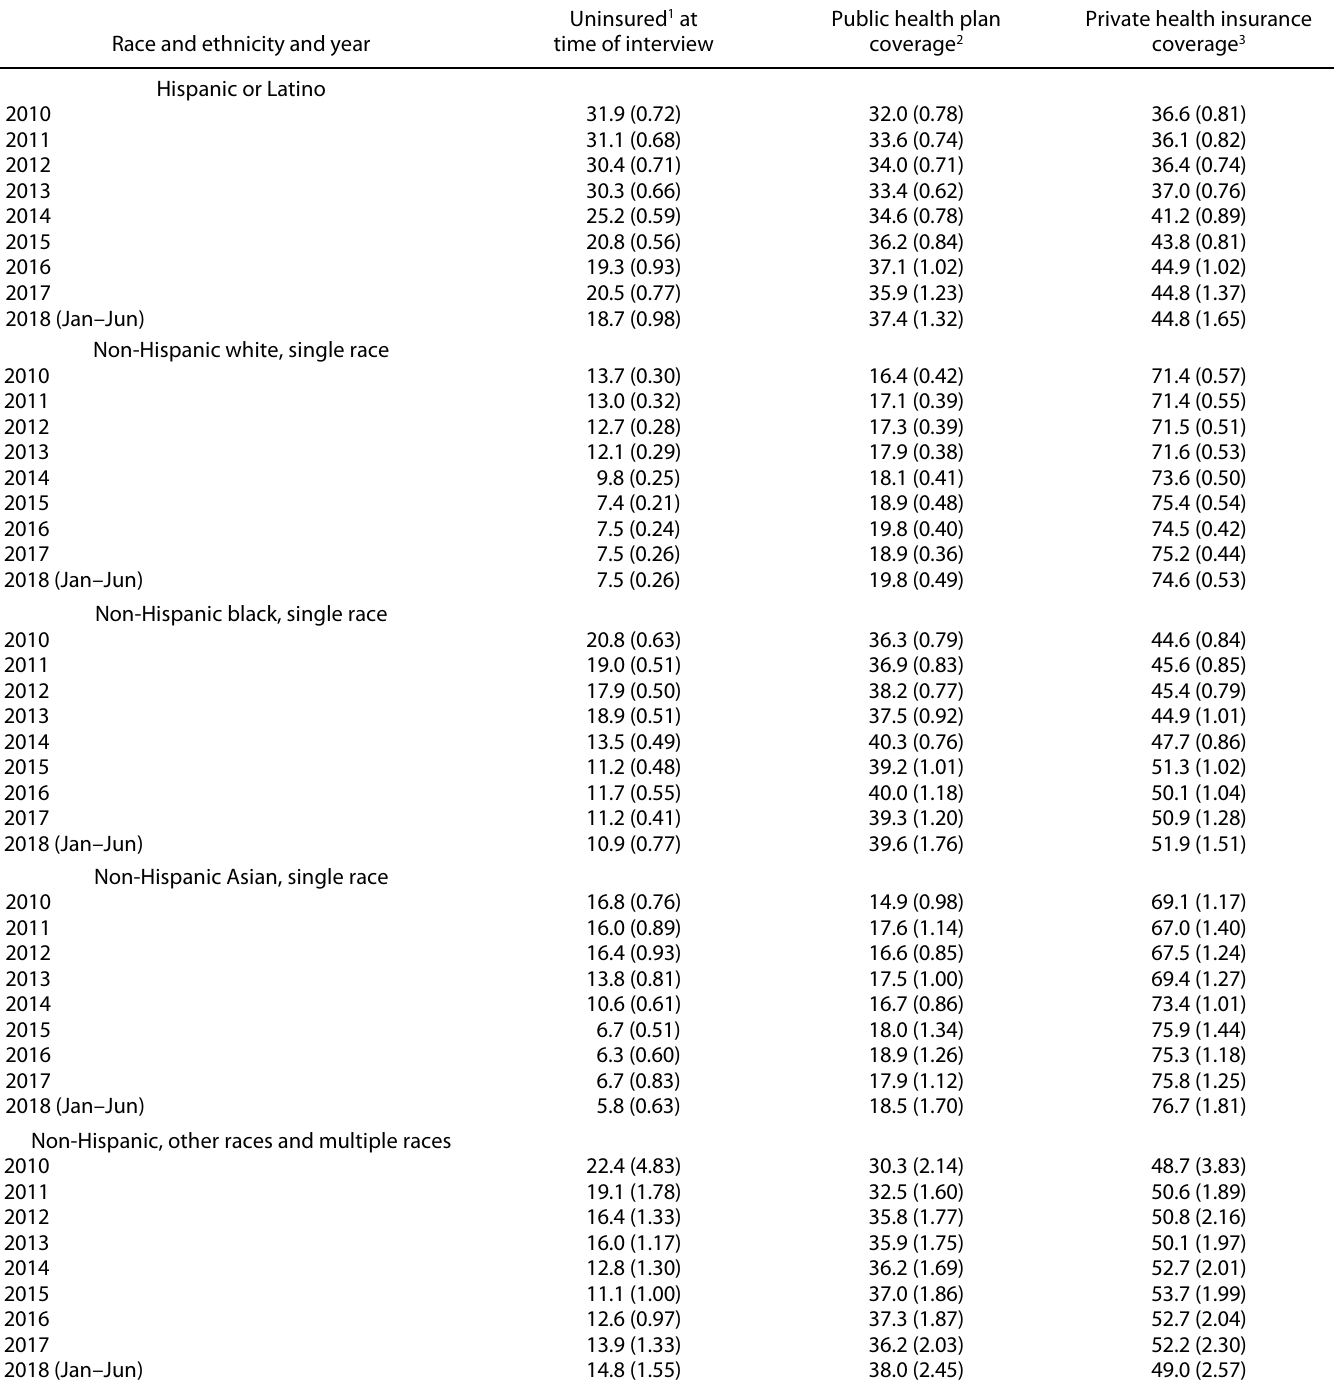
Table VIII. Percentages (and standard errors) of persons under age 65 who lacked health insurance coverage, had public health plan coverage, and had private health insurance coverage at the time of interview, by race and ethnicity and year: United